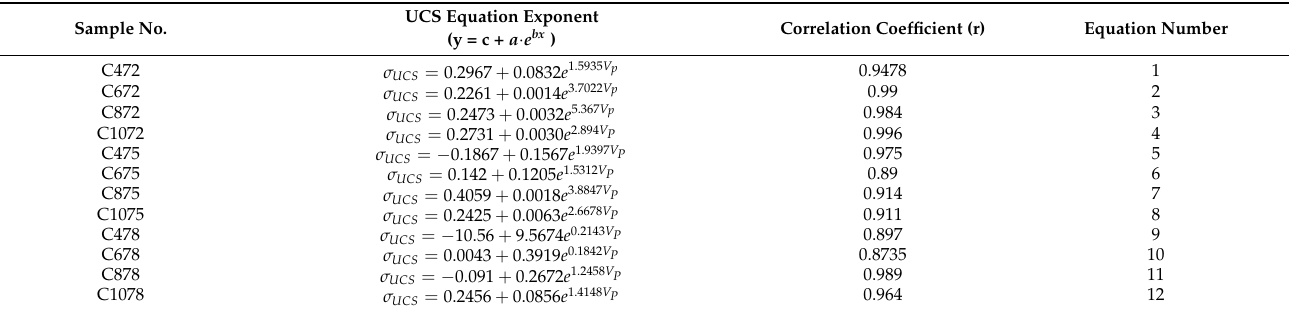
Table 6. Correlation between UPV and